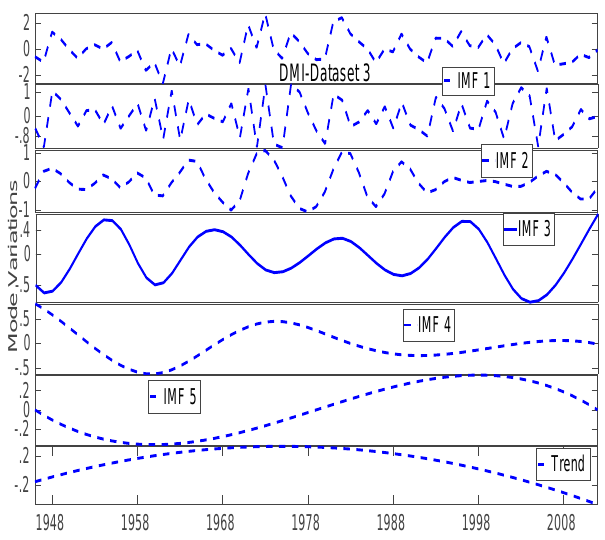
Figure 8. The EMD of the DMI signal in the North Indian Ocean is illustrated in the adjoining figure. The signal here is derived using the Dataset-3. Table 7. Correlation Coefficient (CC) values of the DMI modes and the signal derived from